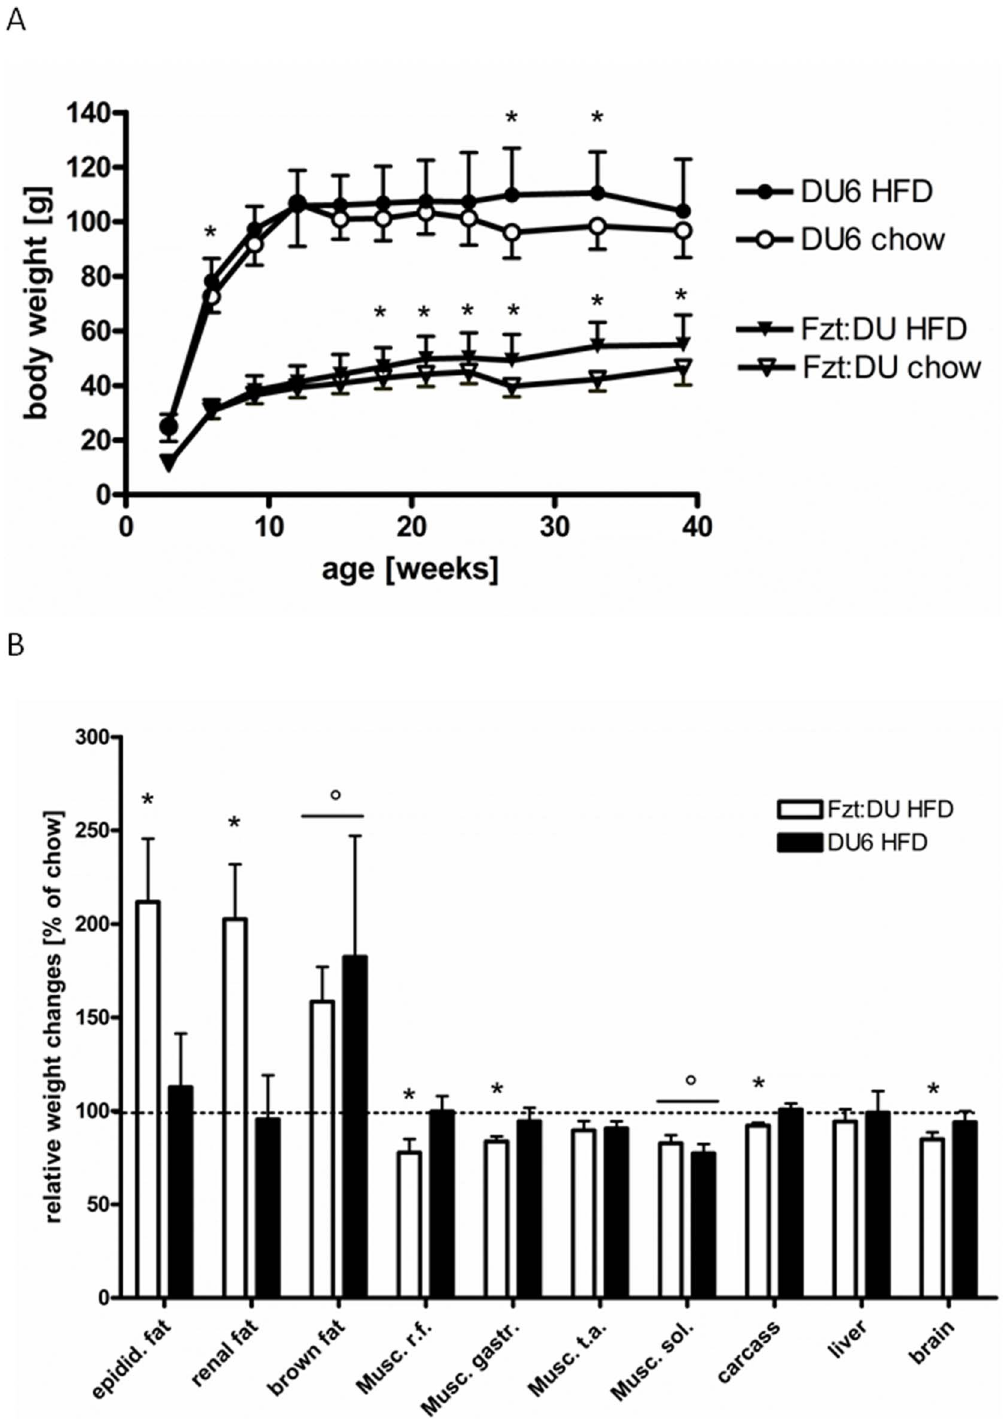
Figure 2. Changes in body and organ mass over life-time under chow and HFD. Effects of a HFD on body weight in male mice (Fig. 2A; until week 27: n . 14; week 33 and 39: n . 7; week 33: P , 0.05). Fig 2B: Effects of a HFD on tissues masses in male mice at an age of 39 weeks (n . 7; *: significant effect of line*diet P , 0.01 vs. chow diet (100%); u : significant effect of diet as a main effect in both lines: P , 0.05 (epidid. fat: epididymal fat mass; Musc. r.f.: Musculus rectus femoris, gastr: gastrocnemius, t.a.: tibialis anterior; sol.: